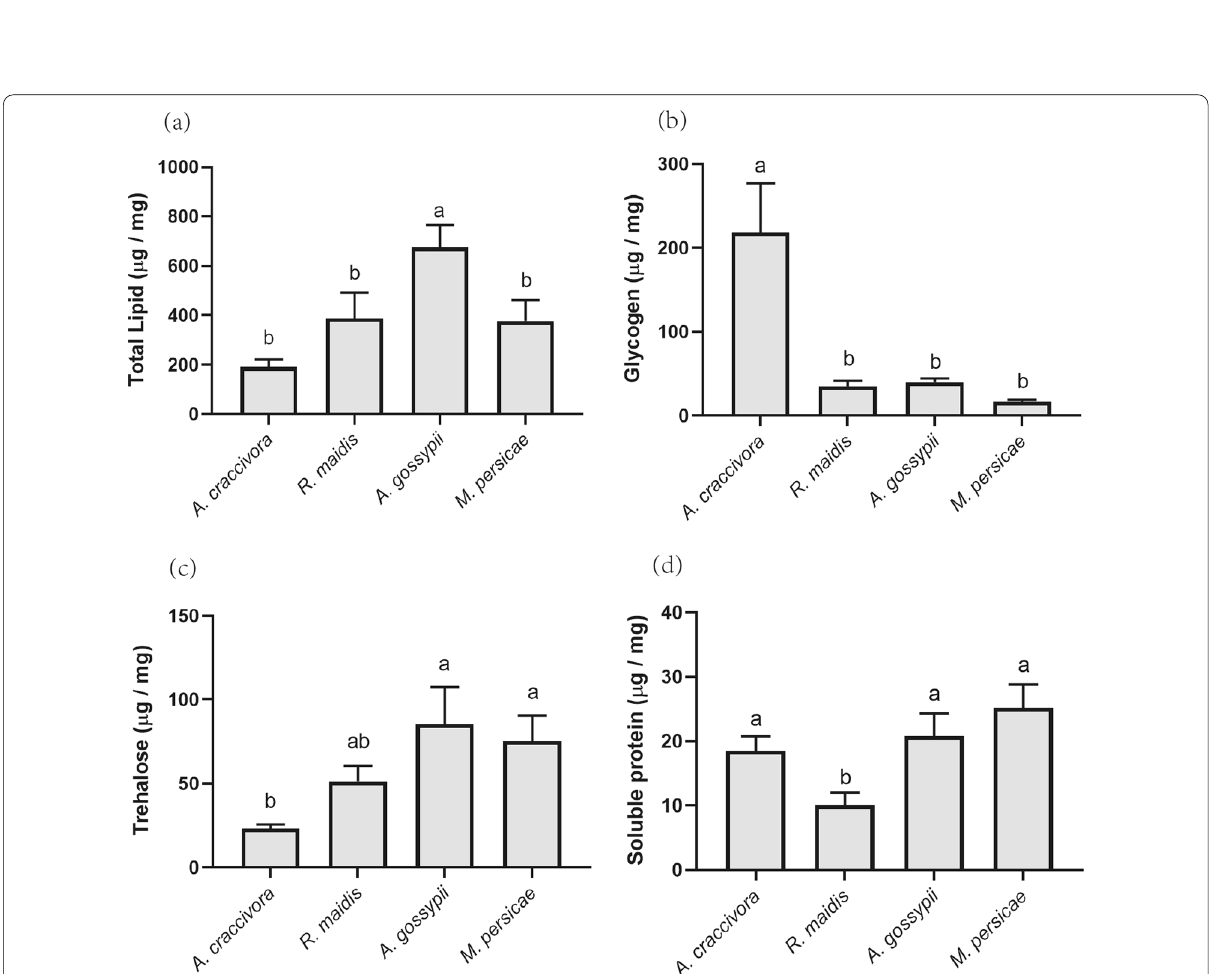
Fig. 4 Total lipid ( a ), glycogen ( b ), trehalose ( c ), and soluble protein ( d ) content (ug/mg fresh weight) of four aphid species (total lipid: n glycogen: n 8–9; trehalose: n 5–9; soluble protein: n 6–9). Values are mean SE. The data were compared by ANOVA followed by LSD test with = = = ± α 0.05, and means indicated by the same letter are not significantly =